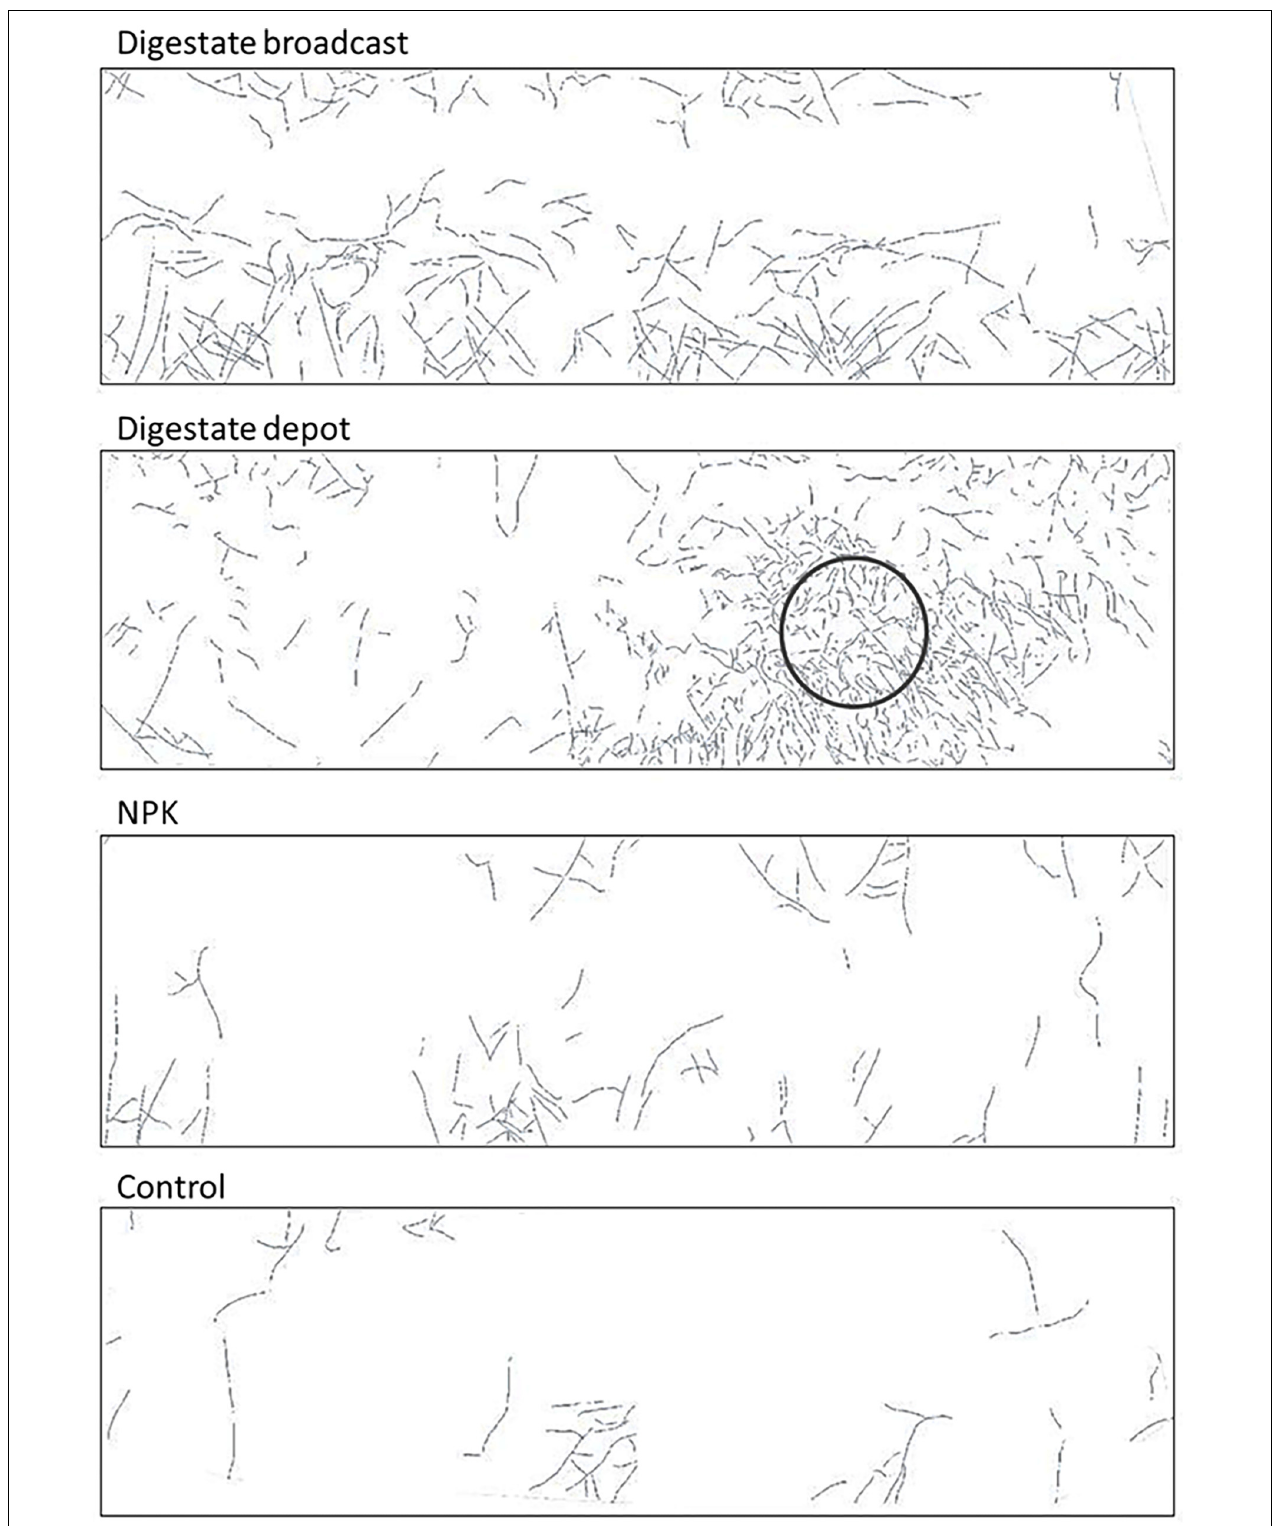
FIGURE 6 | Root distribution of S. hermaphrodita cultivated in mesocosms measured by mini-rhizotrons after 2 years in 30 cm depth: roots form a dense root cluster in the depot-fertilized zone. Control: no fertilization; Digestate broadcast: homogeneous surface application; Digestate depot: localized digestate application; NPK homogeneous surface application. Pictures show a representative example of n = 4 replicates for each treatment and time of harvest.